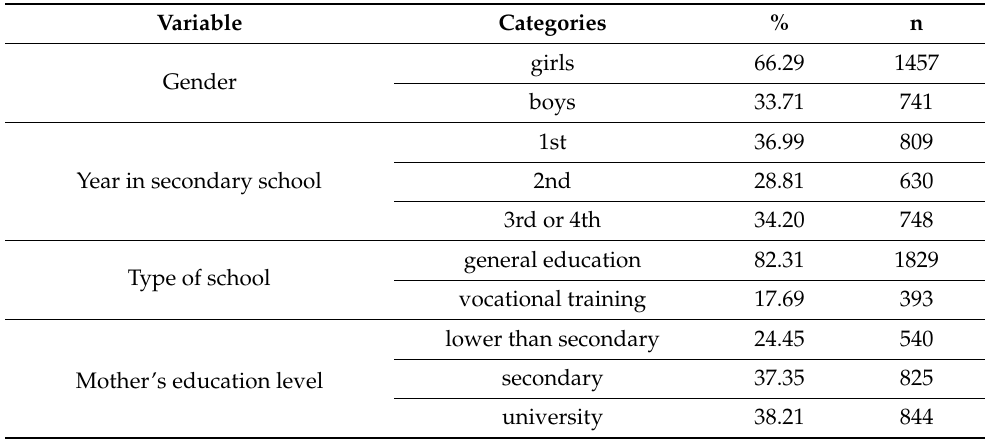
Table 1. Characteristics of the study